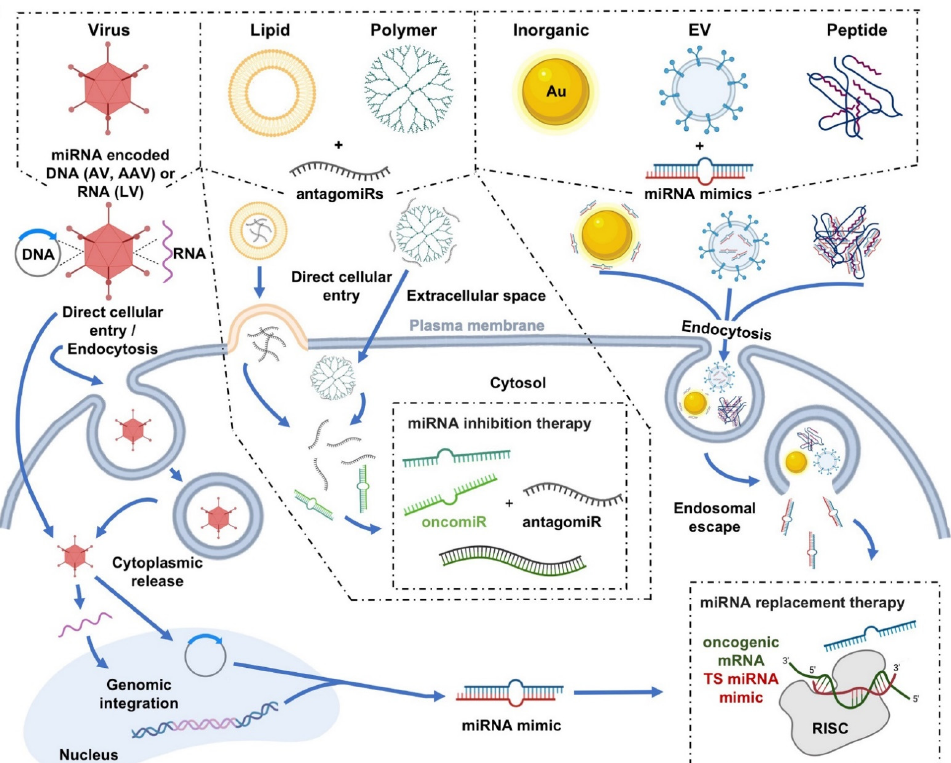
Figure 2. Graphical depictions highlighting the varied miRNA delivery platforms developed for cancer therapeutics, as well as their mechanisms of cellular internalization. Schematic diagram illustrating the generalized modes of cell entry for both viral and nonviral miRNA delivery systems. To cross the plasma membrane of the targeted cell, many of the delivery systems utilize multiple different cellular entry routes, but in general, utilize either direct cellular entry mechanisms or endocytosis-based uptake pathways [70,71]. For example, viral vectors, such as adenovirus (AV), adeno-associated virus (AAV), and lentivirus (LV), can utilize either direct entry mechanisms or endocytosis-based uptake pathways in their delivery of miRNA mimic-encoded RNA/DNA cargo into cells. Other examples, in terms of nonviral delivery systems, can include direct cytoplasmic entry via lipid fusion of a lipid-based vector with the plasma membrane or direct cellular entry of a polymer (e.g., polyamidoamine (PAMAM))-based vector in the delivery of antagomiR cargo. Additionally depicted are examples of cellular internalizations via endocytosis of inorganic (e.g. gold (Au)), extracellular vesicle (EV), and peptide-based vectors in complex with miRNA mimic cargo. Select images within the figure were acquired from